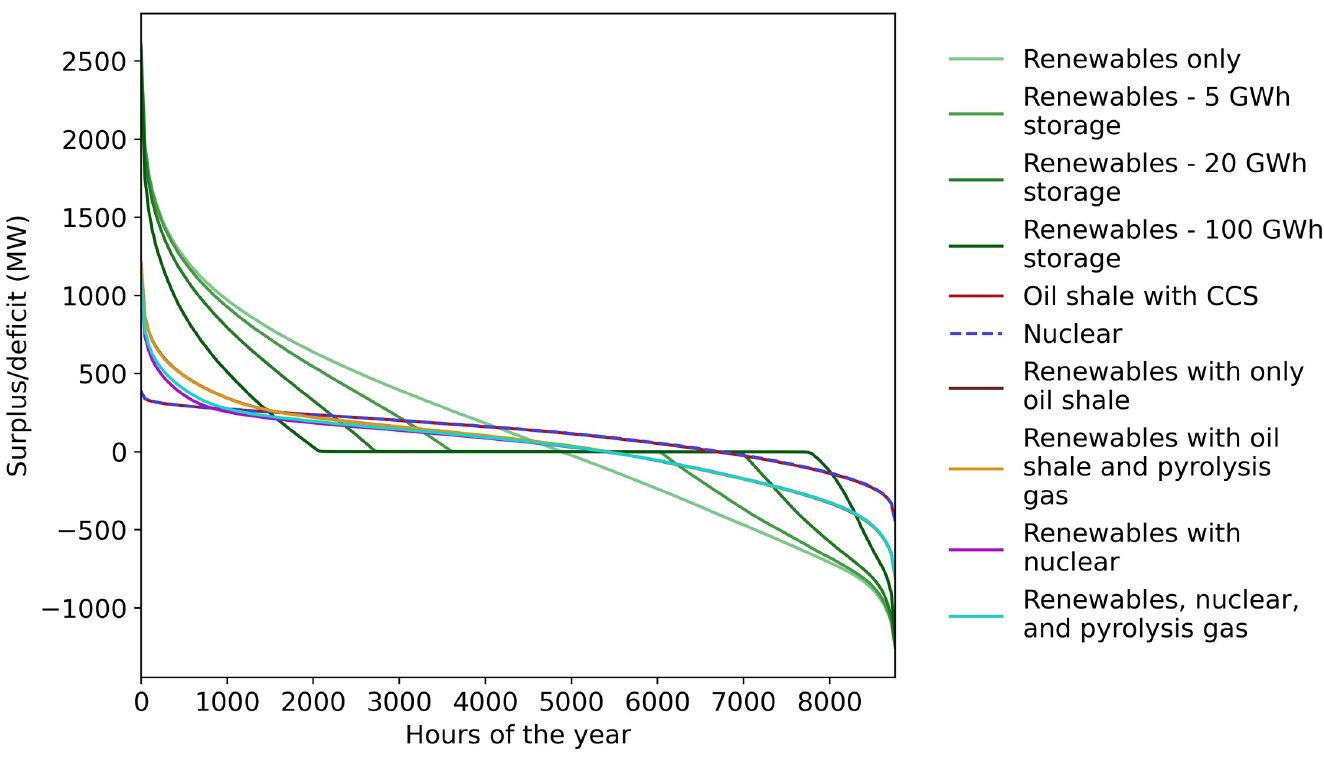
Fig 6. Surplus duration curves for the scenarios